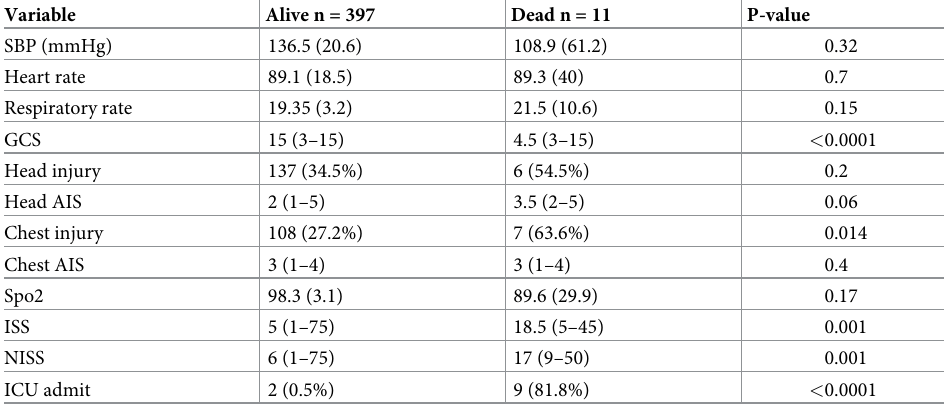
Table 2. Two-sample data analysis comparing the severity markers of hospitalized facial injury patients who died with those who survived during the period of 2014–2017 at Al-Ain Hospital, Al-Ain City, United Arab Emirates.